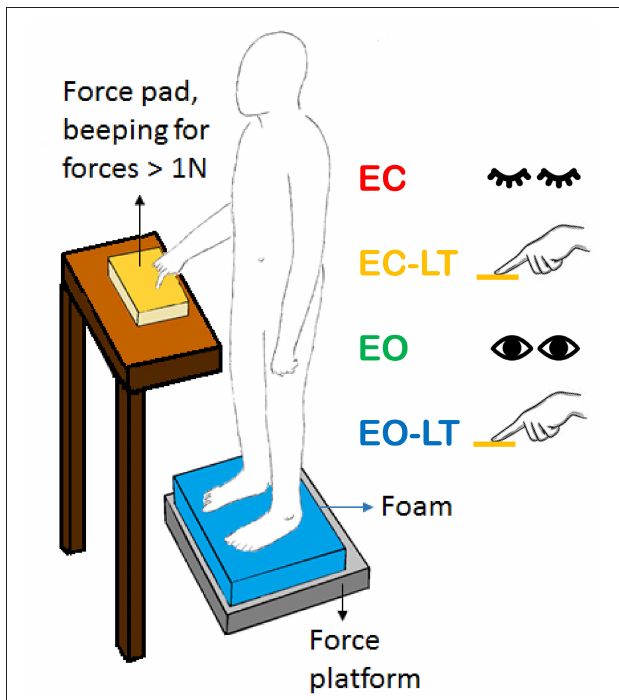
FIGURE 1 | Sketch of the test situation showing a standing subject in front of the force pad (yellow) during the light-touch (LT) trials. The force pad device beeped when the force exceeded 1N. Subjects rarely reached this force level during the trials. In the sketch, the foam is shown (blue). In the absence of touch, both arms were along the trunk. The same position(s) were assumed with the eyes closed (EC) or open